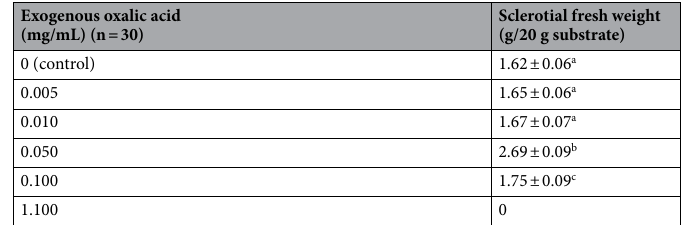
Table 1. Effect of exogenous oxalic acid on P. umbellatus sclerotial differentiation. The values were presented as the means ± SD from at least three independent experiments, with 30 replicates of each group. Significant differences were determined using the Student–Newman–Keuls method, and the values followed by different letters (a, b, and c) are significantly different ( P <